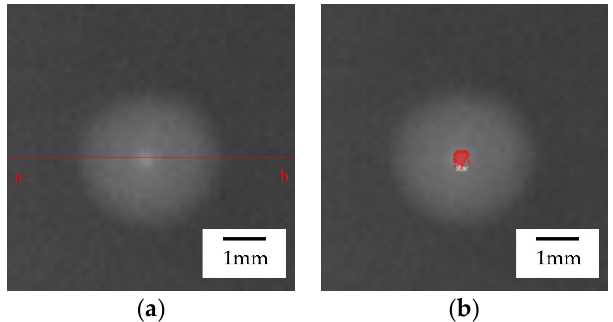
Figure 3. ( a ) Binary droplet image of feature to be extracted. ( b ) Experimental image after detection by Mask R-CNN (where the red area is the highlight area and the feature area is called “star”).